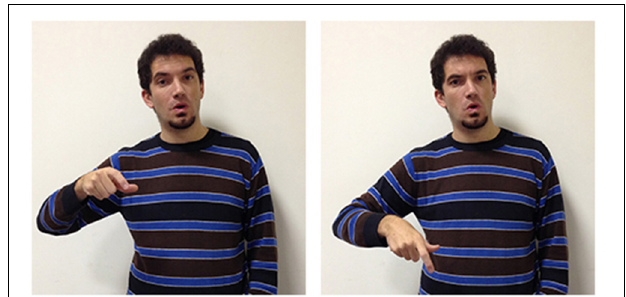
FIGURE 7 | LIS sign BY FORCE .